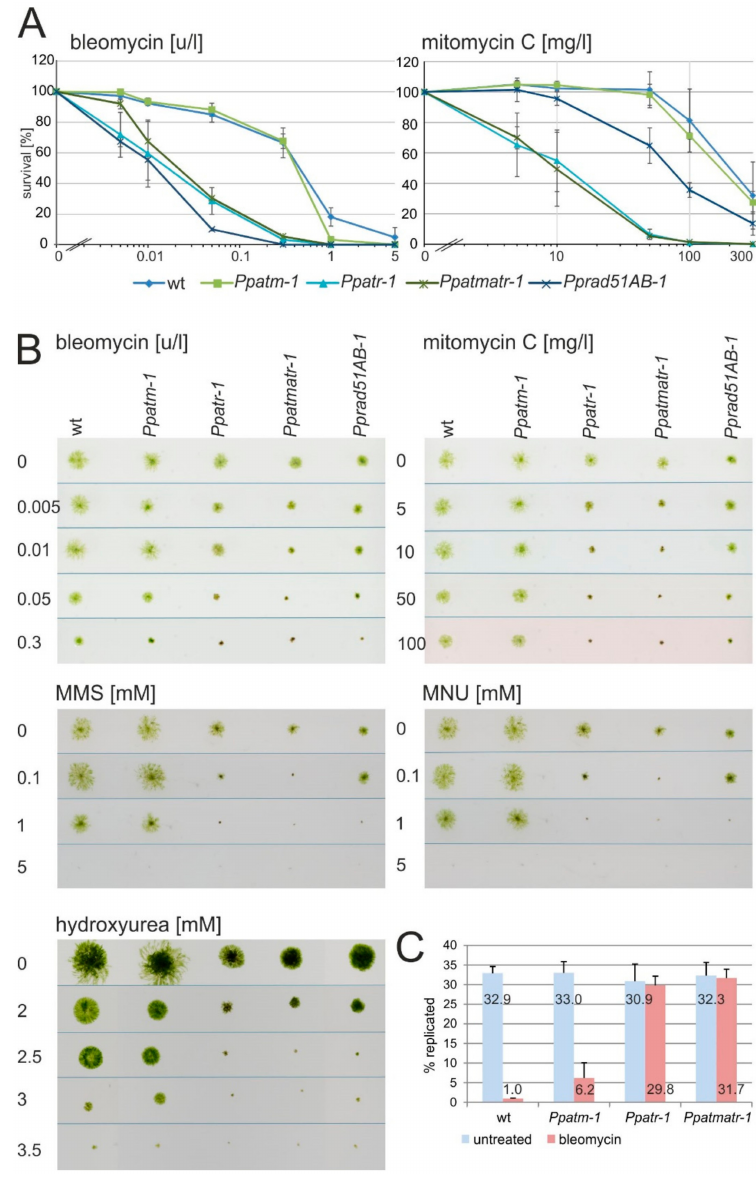
Figure 3. DNA damage resistance and checkpoint control assays. ( A ) Acute assays. The survival curves for wild type and Ppatm-1 , Ppatr-1 , Ppatmatr-1 , and Pp rad51AB-1 mutants calculated as a percentage relative to the mock treatment are shown in log [10] scale. Data are the mean ( n = 2) +/ - SD. ( B ) Chronic assays. The pictures show colonies after 14 (28 for hydroxyurea) days of growth in the presence of the indicated concentrations of genotoxins under standard conditions. ( C ) Checkpoint control assays. The graph shows the number of replicated (Alexa488-fluorescent) cells as the percentage of the total number of stainable (DAPI-positive) cells in 20 independent colonies in mock (untreated) and bleomycin-treated (bleomycin) plants. Data are the mean ( n = 3) +/ - SD. Concentrations are in units active substance per liter (u / L), milligrams per liter (mg / l), or millimolars